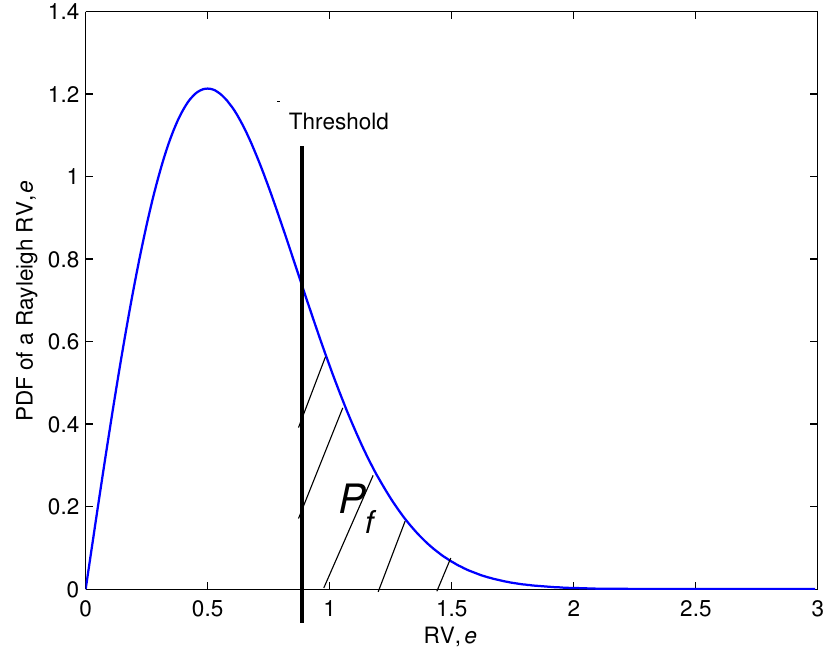
Figure 13. PDF of the Rayleigh RV, e